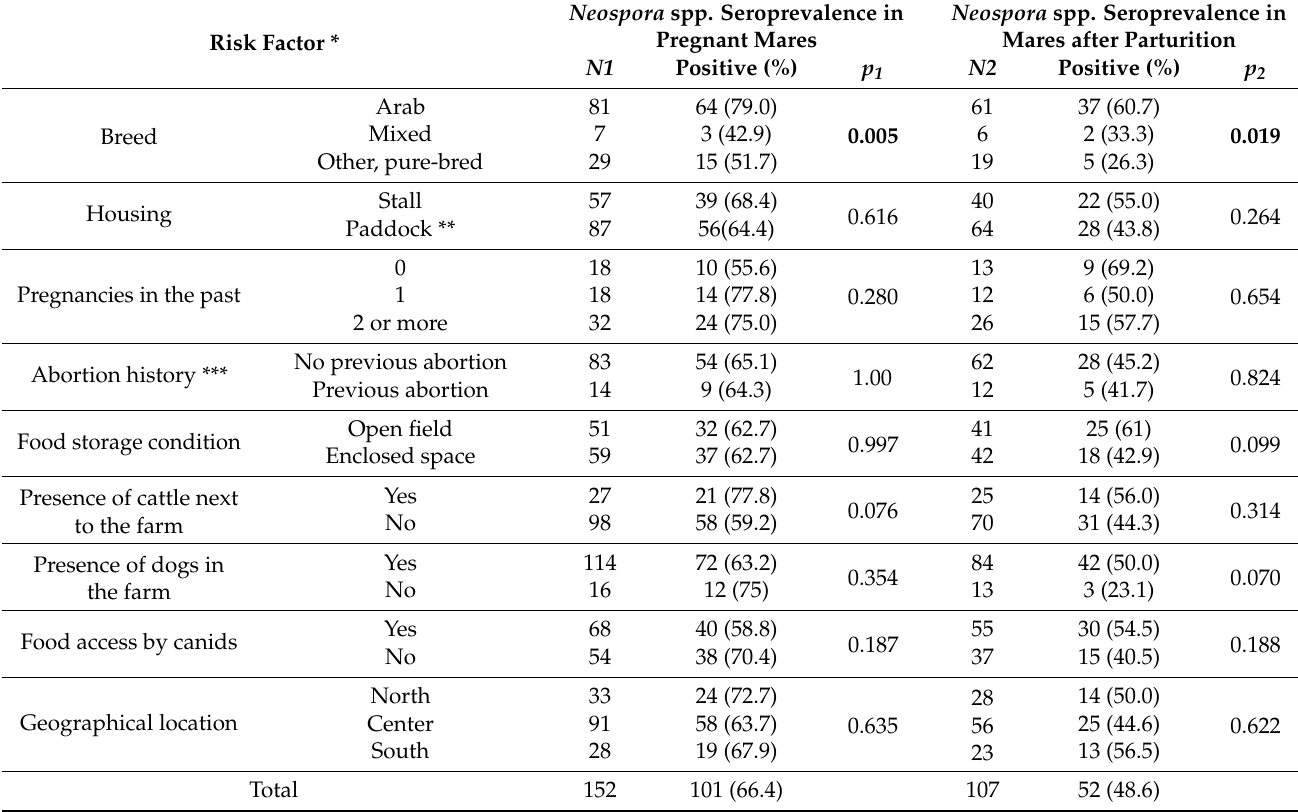
Table 4. Neospora spp. seroprevalence in mares during gestation and after parturition in relation to various descriptive